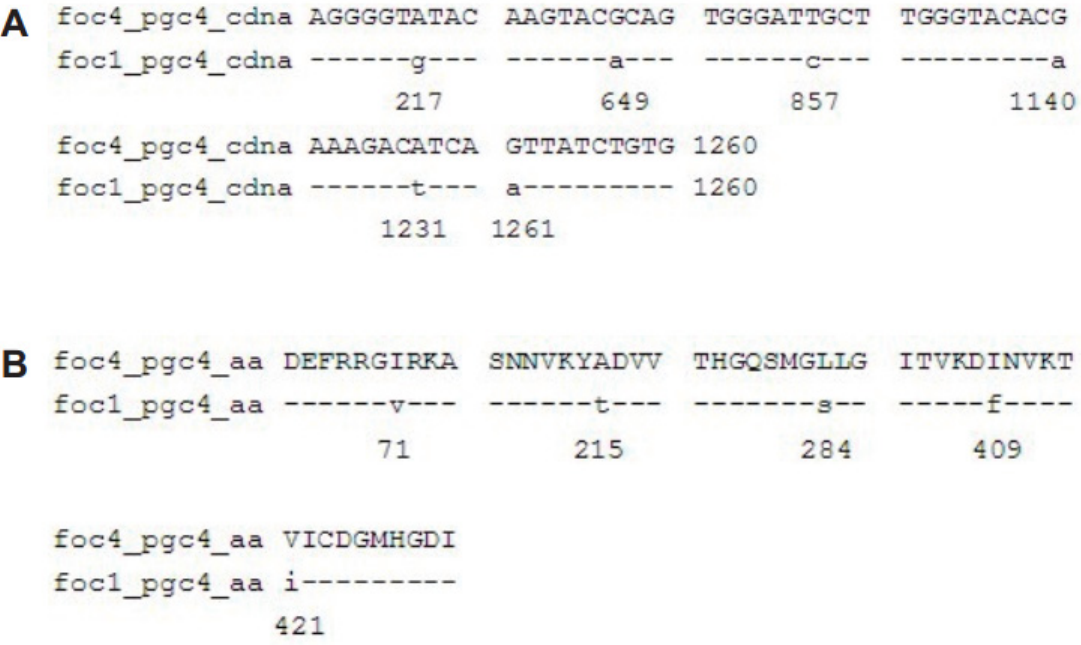
Figure 2. Alignment of the nucleotide sequences and predicted proteins of pgc4 from Foc1 and Foc4. ( A ): Alignment of ORF of pgc4 from Foc1 and Foc4; ( B ): alignment of predicted proteins of pgc4 from Foc1 and Foc4.